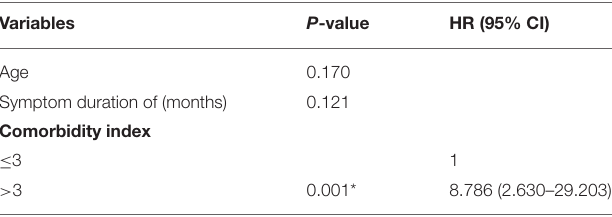
TABLE 4 | In the multivariable analysis, comorbidity was the only prognostic factor negatively influencing VP-shunt outcome. Variables P